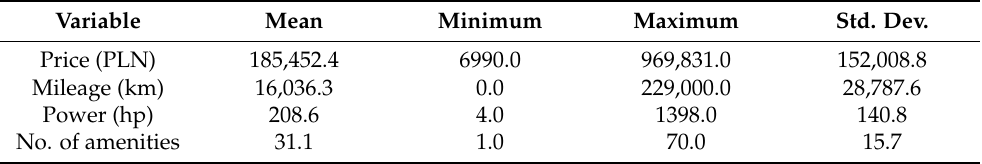
Table 1. Descriptive statistics of analyzed variables based on EV sales